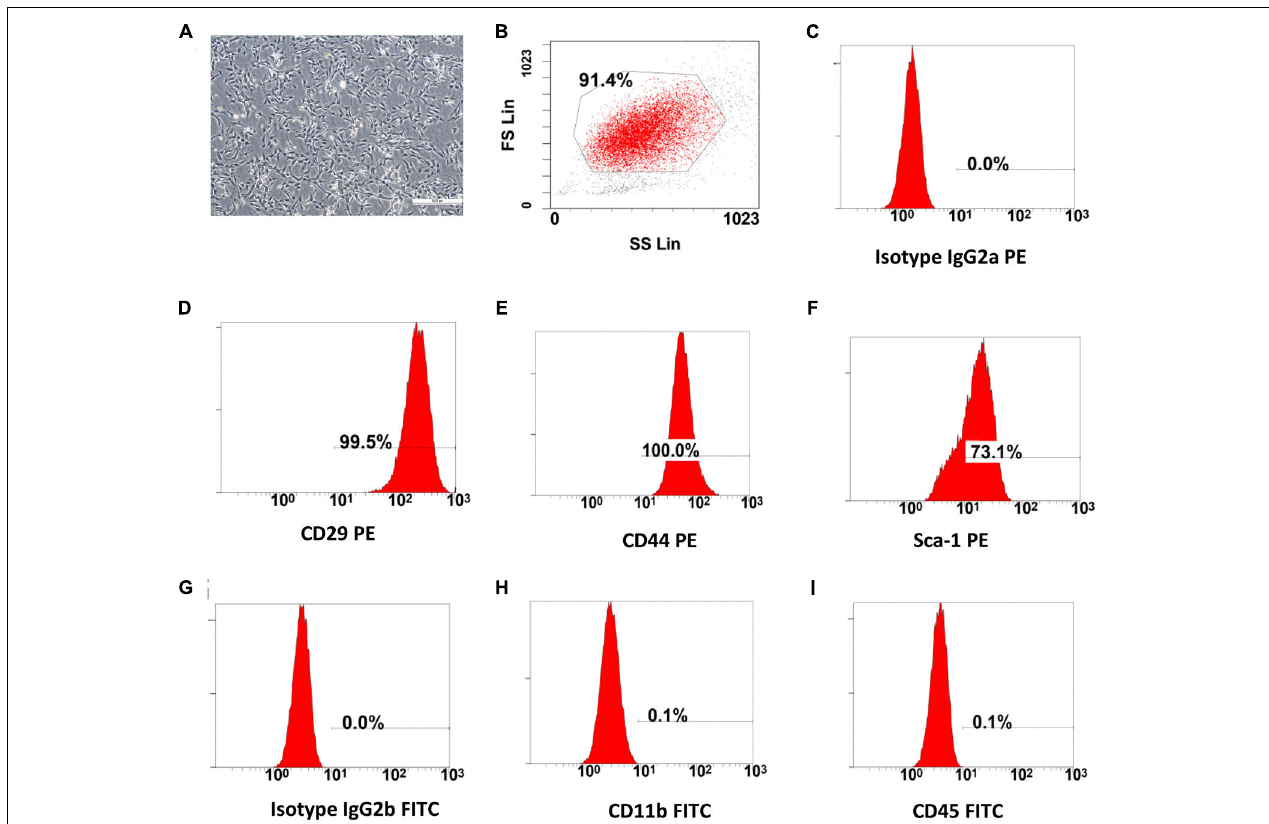
FIGURE 1 | The characterization of BMSCs. (A) Cultured bone marrow mesenchymal stem cells, after three passages (scale bar: 100 µ m). (B–I) Flow cytometry (FC) analysis for cell surface antigens. The morphology (fibroblast-like cell) and cell-surface marker (CD29, CD44, Sca-1 High and CD11b, CD45 Low) of the cultured BMSCs were compliant with the standards of mesenchymal stem